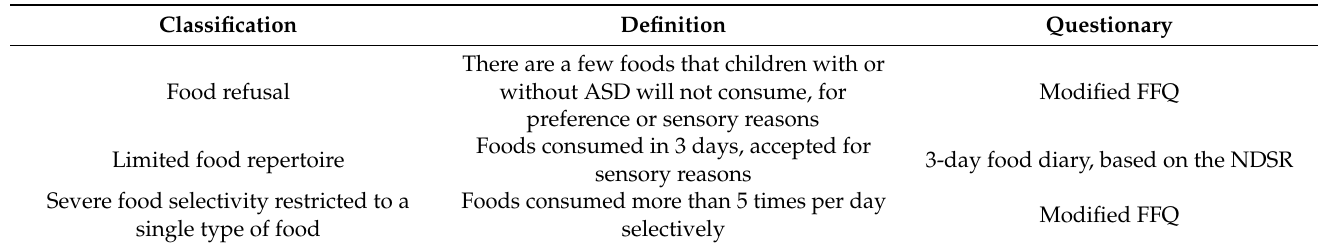
FFQ: food frequency questionnaire; NDSR: Nutrition Data System for